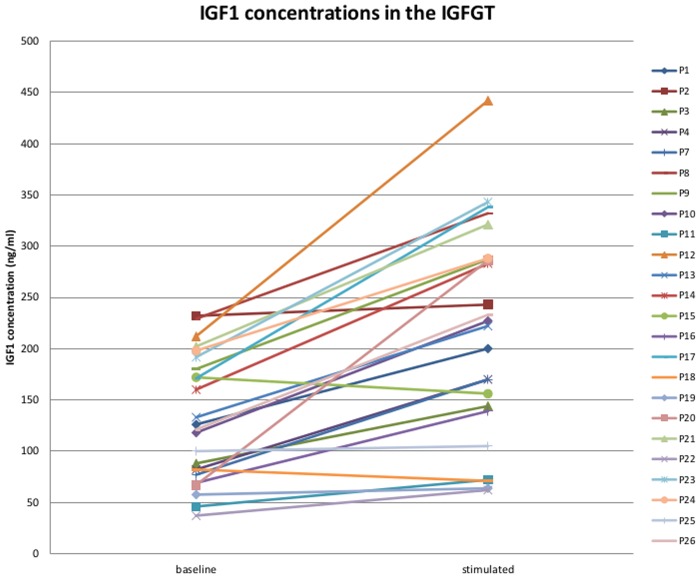
Increase of IGF1 concentration upon rhGH treatment in the IGFGT.Scatter plot of the IGF1 concentrations (ng/ml) at baseline and rhGH stimulated blood sampling among the short-term rhGH treatment study cohort. The two measurements per sample are connected. Sample numbering corresponds to the sample identifier in Table 1. A significant increase in IGF1 concentrations after rhGH treatment is observed (paired t-test, p = 1.93 x 10–6).